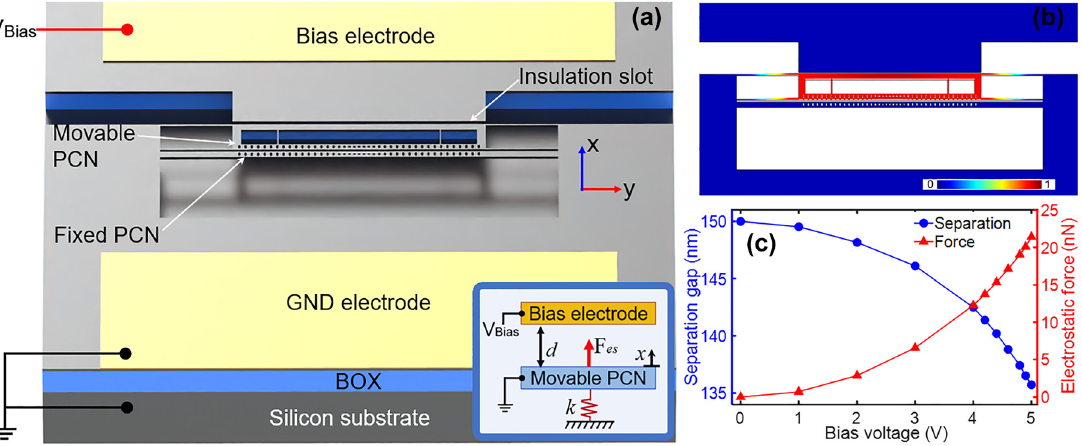
Figure 1: Overview of the nanoscale optomechanical electrometer. (a) Schematic diagram of the electrometry integrated with an optomechanical zipper cavity. Inset: Schematic of the optomechanical electrometry based on a parallel-plate capacitor. (b) The normalized FEM deflection of movable PCN forced by an electric potential. (c) Simulation results of the nanoscale capacitor under the applied bias voltage, the blue data point is the lateral separation of the isolation gap while the red data point shows the electrostatic force induced by the applied